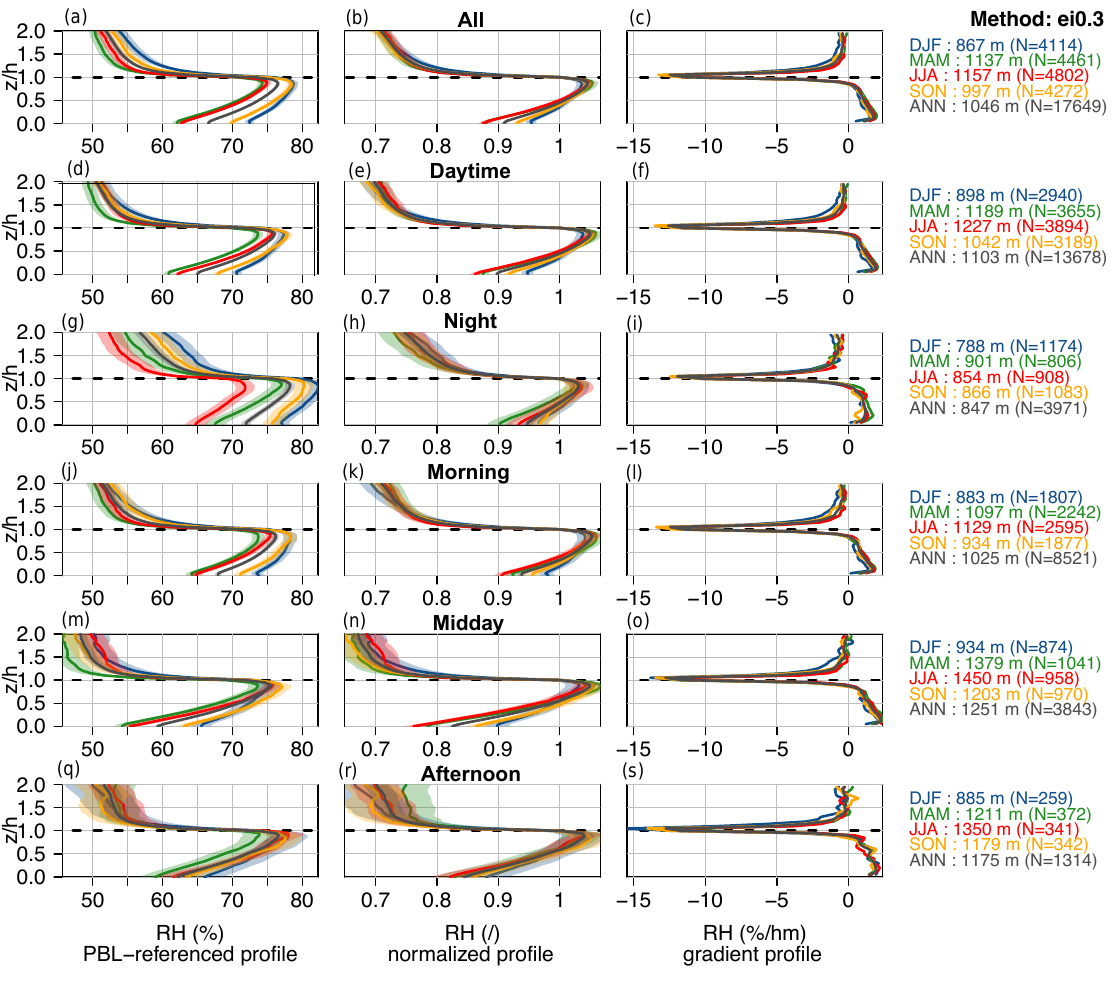
Figure 9. Same as Fig. 7 for RH (in %).